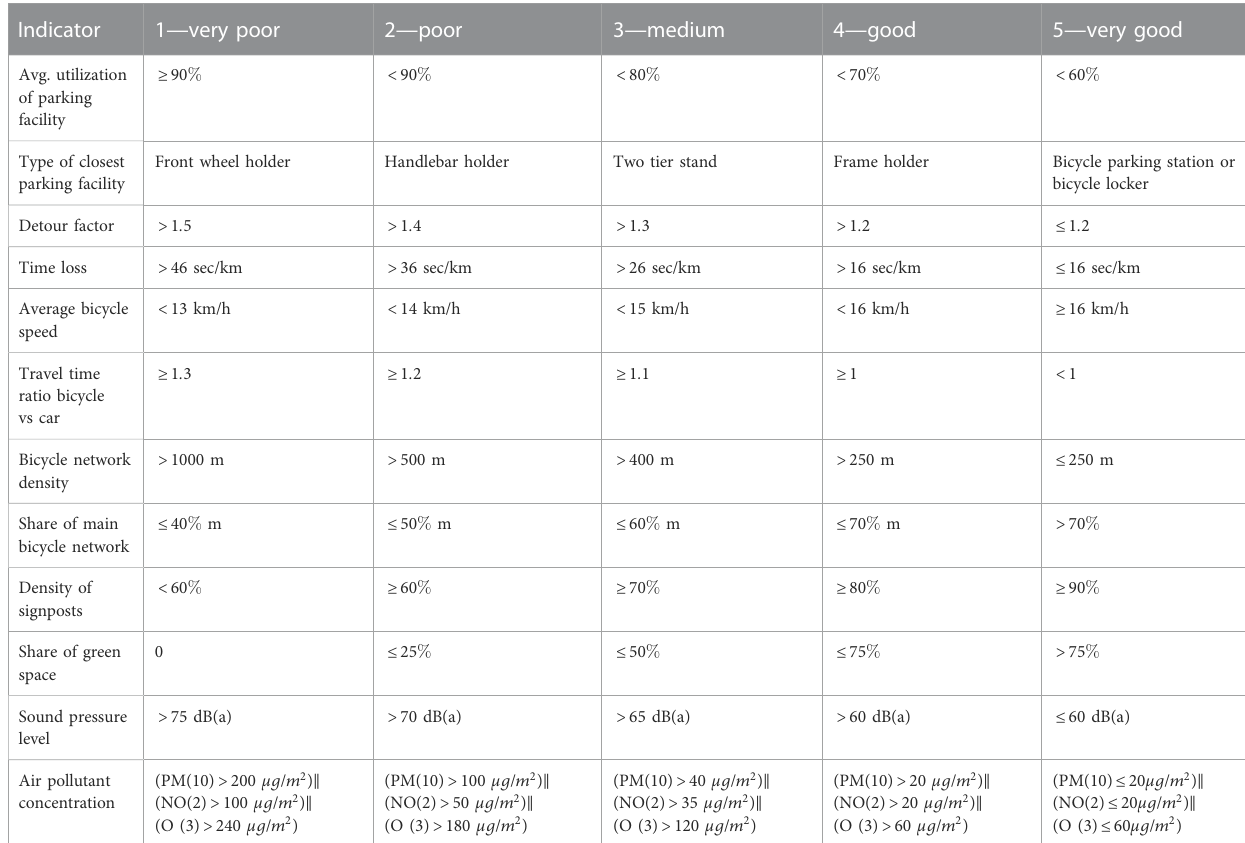
TABLE 8 Indicators: evaluation scales — part II.